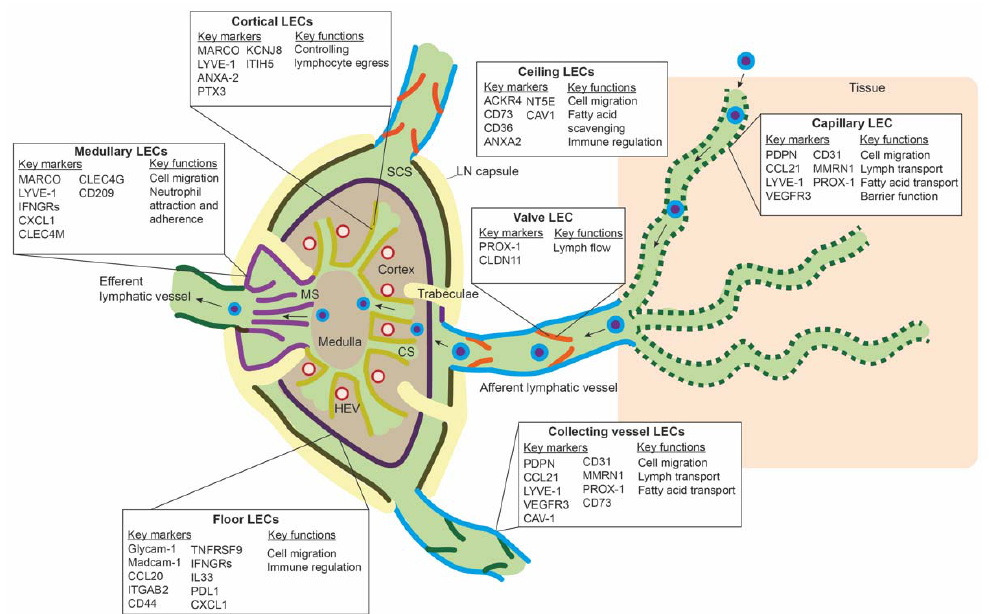
Figure 2. Overview of the different lymph node lymphatic endothelial cells and peripheral lymphatic endothelial cell subpopulations. The lymph node (LN) consists of multiple sinuses to transport lymph and immune cells from the afferent lymphatic vessels to the efferent lymphatic vessel. Immune cells arrive in the subcapular sinus (SCS) and migrate over the floor of the SCS, lined by floor LECs, to the LN cortex. The SCS is a narrow sinus, and it is close to the LN capsule. The LN capsule side of the SCS is lined by ceiling LECs. In the LN cortex, immune cells also arrive via high endothelial venules (HEVs). Egress of immune cells from the cortex is via the cortical sinuses (CS) lined by cortical LECs. These cortical sinuses drain in the medulla. Medullary sinuses (MS), lined by medullary LECs, transport lymph and immune cells to the efferent lymphatic vessel. LECs lining the different sinuses were found to be transcriptionally different and to have a range of different functions.